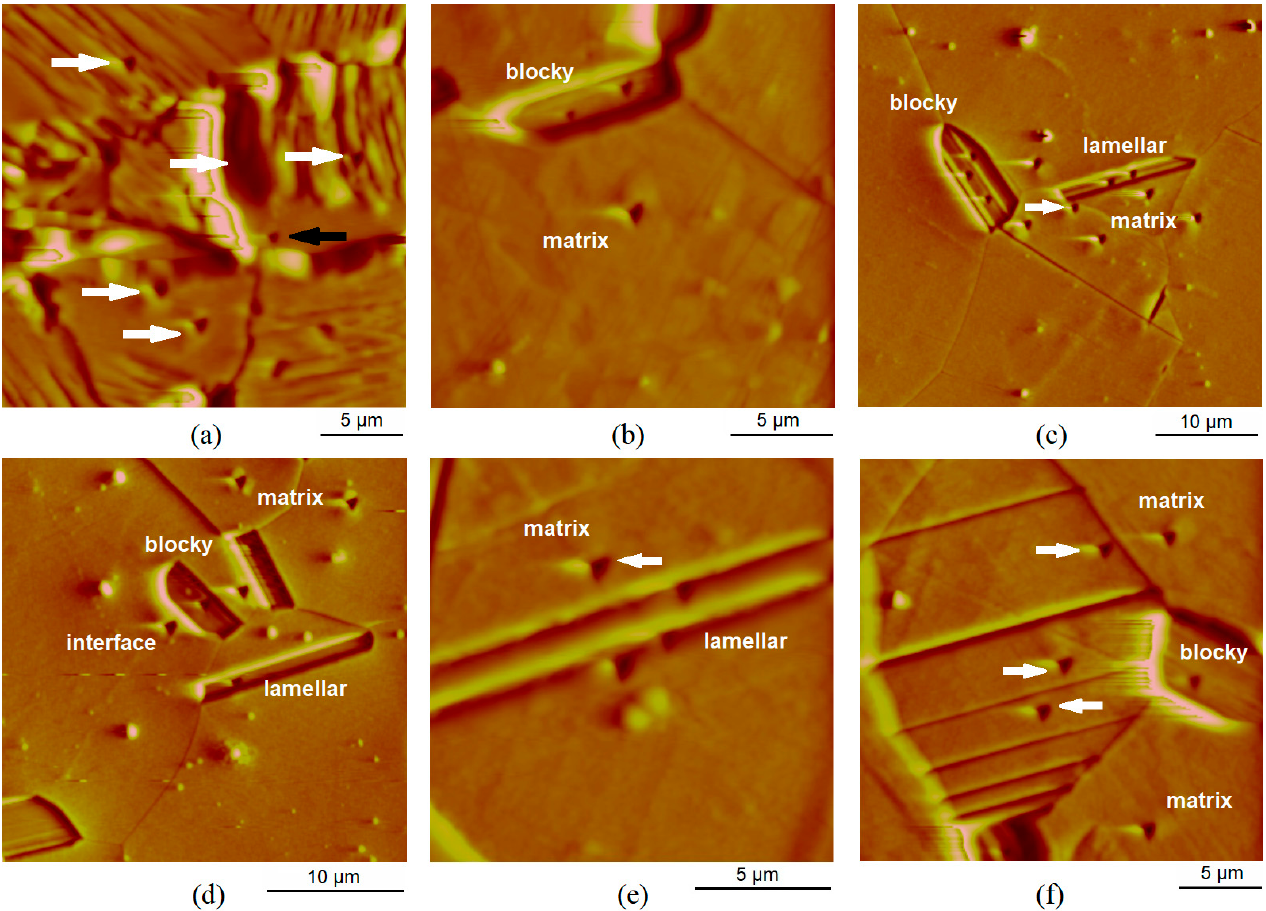
Figure 12. Nanoindenter AFM images with indents of Mg-Dy-Nd-Zn-Zr alloy in as-extruded ( a ) and solution heat-treated at 500 °C: for 24 h ( b ), for 48 h ( c , d ) and 72 h ( e , f ).